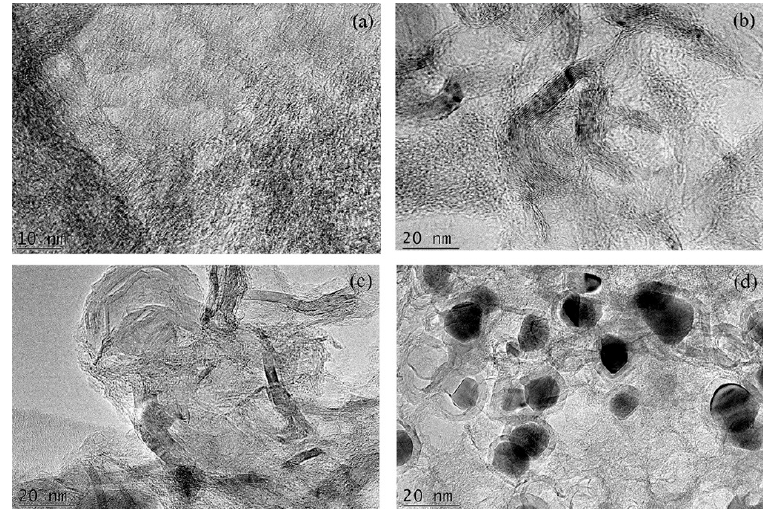
Figure 2. TEM images of carbonized chars with different amounts of FeCl 3 additive ( a ) C-HLH-5, ( b ) C-1FeHLH-5, ( c ) C-2FeHLH-5, and ( d )